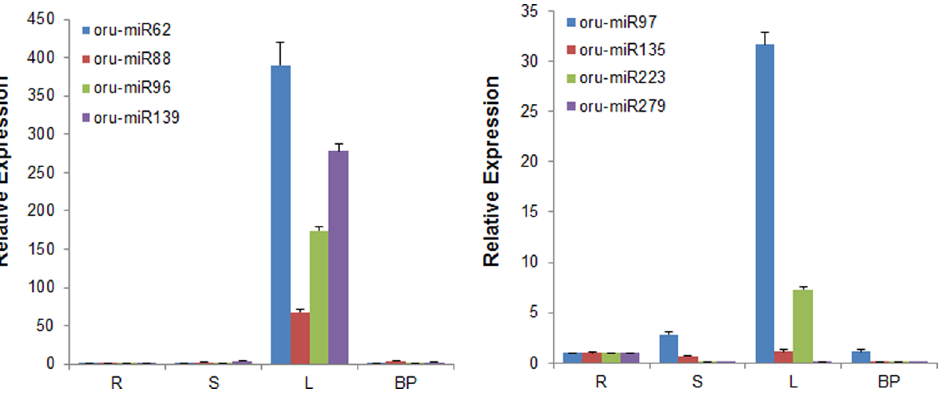
Figure 4. Quantitative real-time RT-PCR analysis of the relative expression of new miRNAs in different rice tissues. OSActin was used as a housekeeping gene control. Real-time PCR experiments were conducted using the primers given in Table S1. The data represent the mean values 6 SD of three replicates. R: root, S: stem, L: leaf, BP: booting panicle.